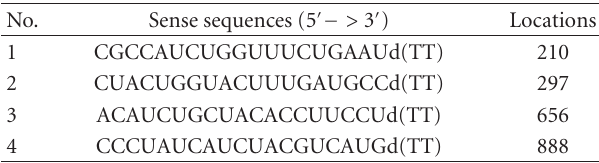
Table 1: Sequences and locations of siRNA